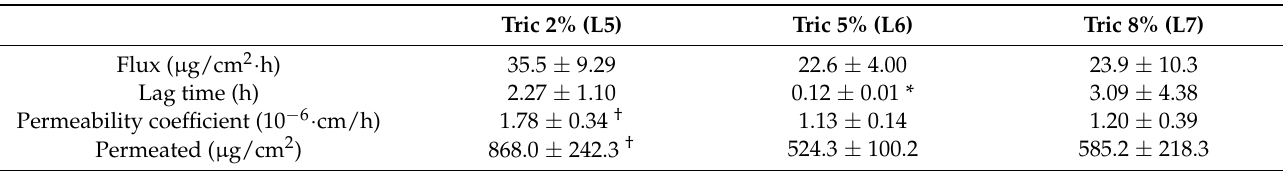
Table 4. Ex vivo permeation parameters of Vit C after topical administration of LOSs with different amounts of tricaprylin on porcine